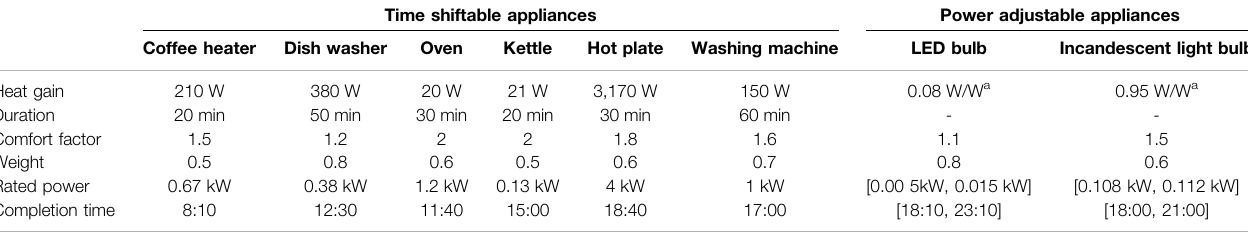
TABLE 2 | Settings of controllable appliances.